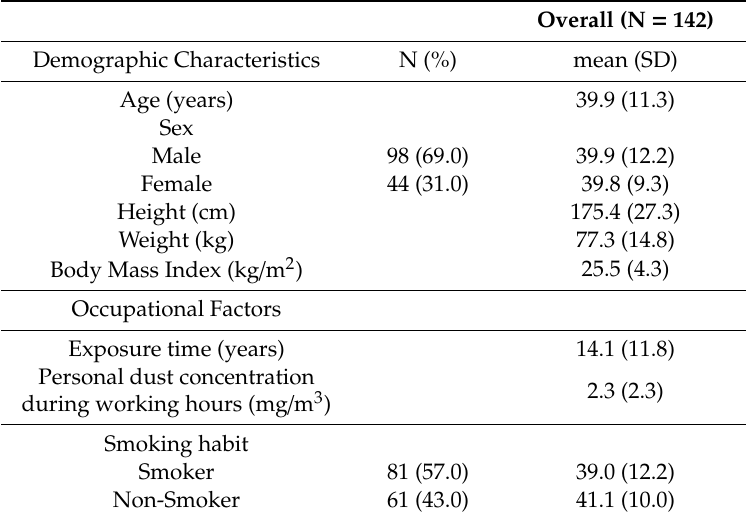
Table 1. Main participants’